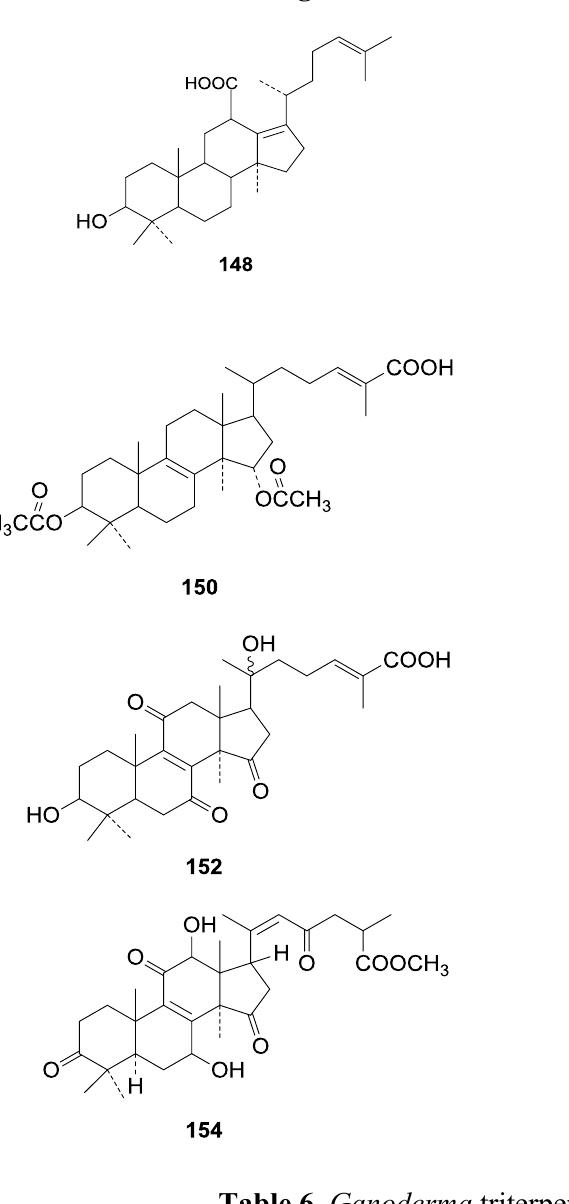
Figure 18. Structures of compounds 148 ‒ 155 .